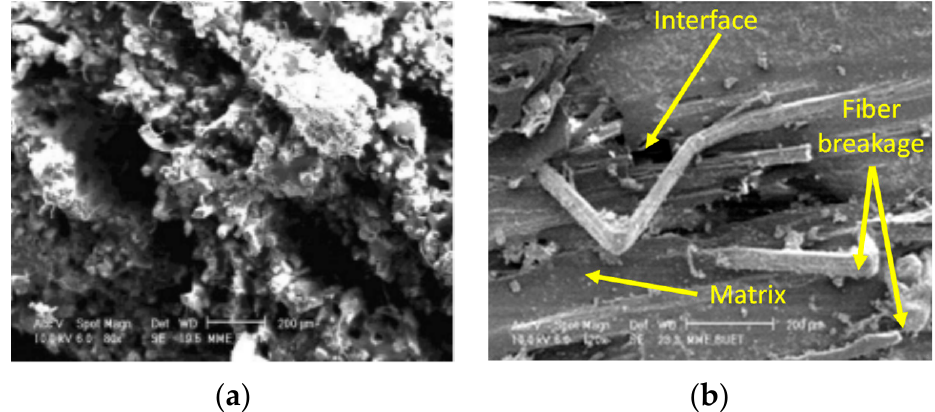
Figure 15. ( a ) Tensile and ( b ) flexural fracture surfaces of jute-epoxy composite [57]. Rahman et al. [58] studied the effect of fiber orientation and jute volume fraction in jute polyester composites on mechanical and thermal properties with a maximum volume fraction of 30%. With a suitable combination of fiber orientation and fiber volume fraction improved mechanical properties were obtained and this type of composite can replace wood-based structures and potential to be used as a thermal insulation material.